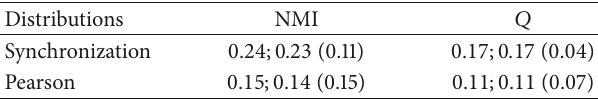
Table 2: Mean and median (interquartile range) quantities of NMI and 𝑄 distributions for the metrics synchronization and Pearson’s